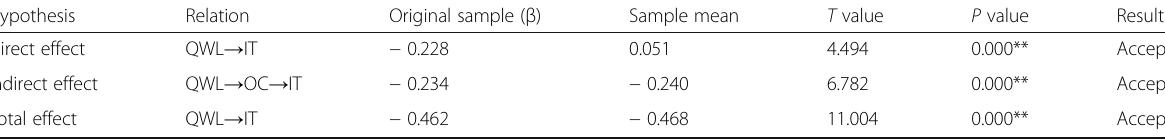
Table 3 Summary of path coefficients and hypothesis testing (mediating results)